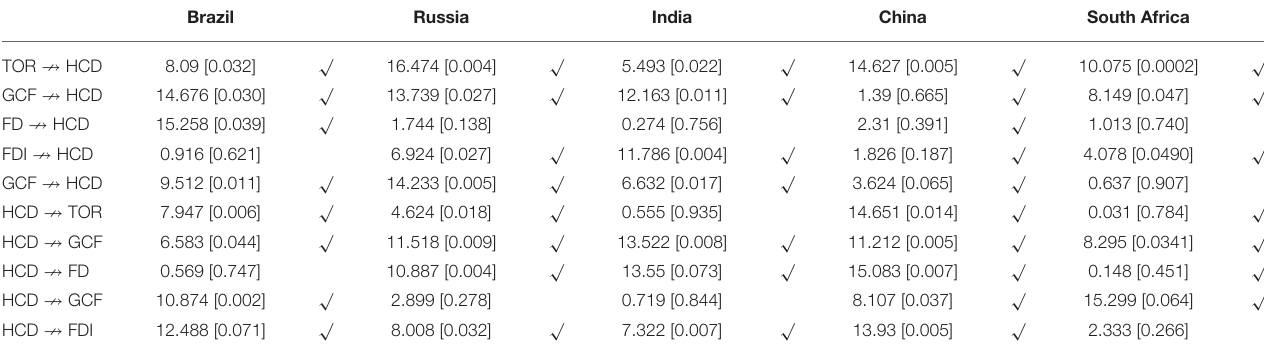
TABLE 10 | Toda–Yamamoto Fourier causality